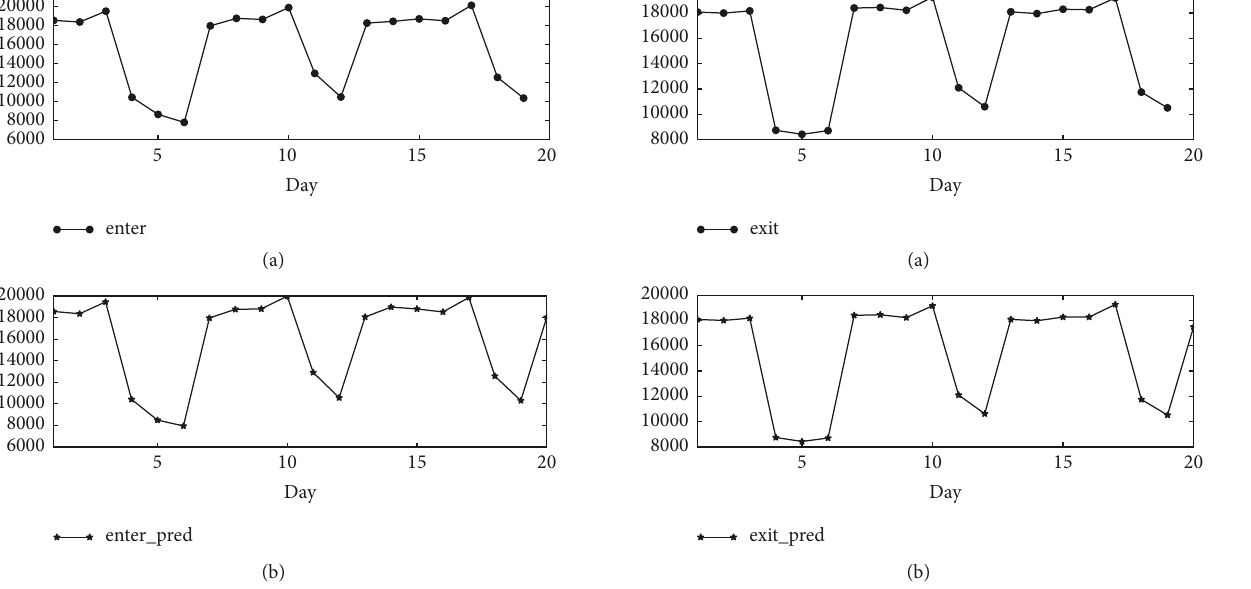
Figure 3: Prediction of daily entrance passenger flow of Dabaishu rail transit station.